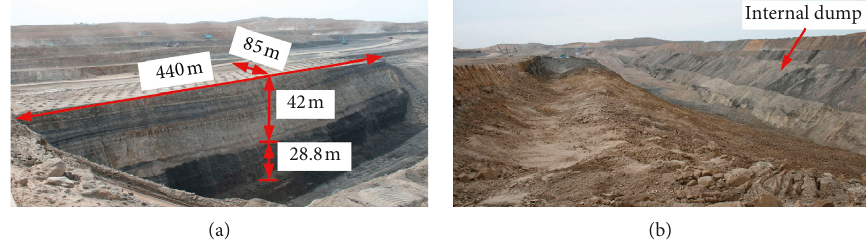
Figure 4: Conditions before, and after, cast blasting. (a) High benches of cast blasting and (b) muck pile of cast